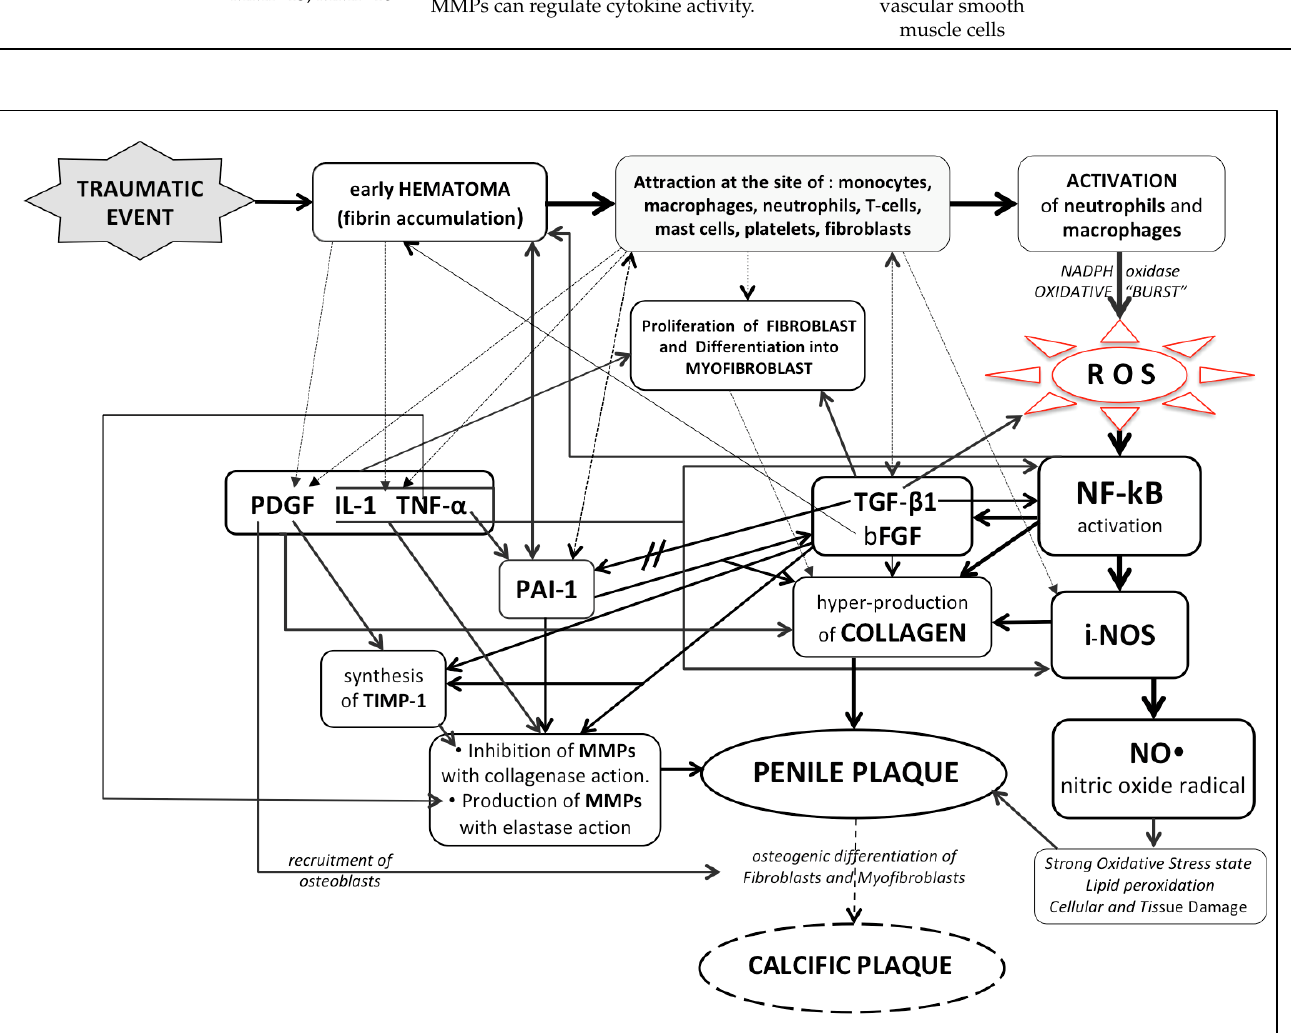
Figure 1. Explanatory algorithm of the pathophysiology of Peyronie’s disease.